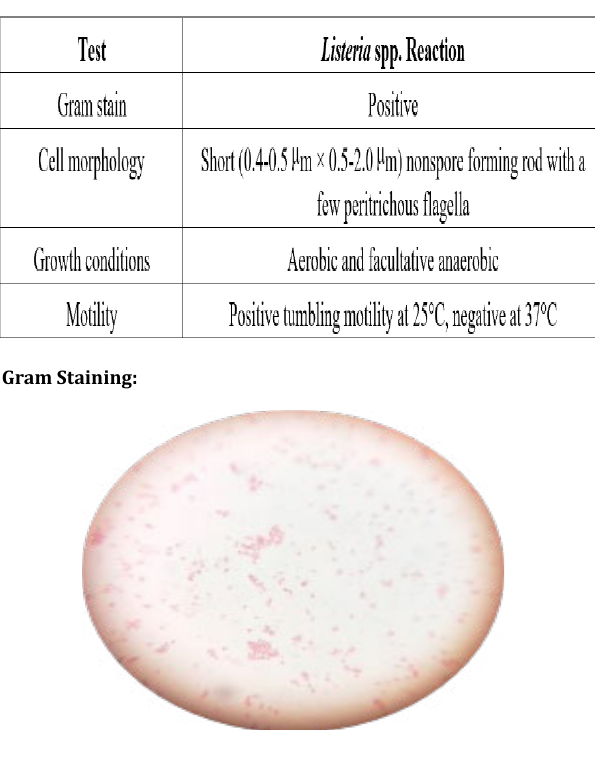
Fig. 9 Staining of bacteria shows short rods, purple color 8. Biochemical Tests: